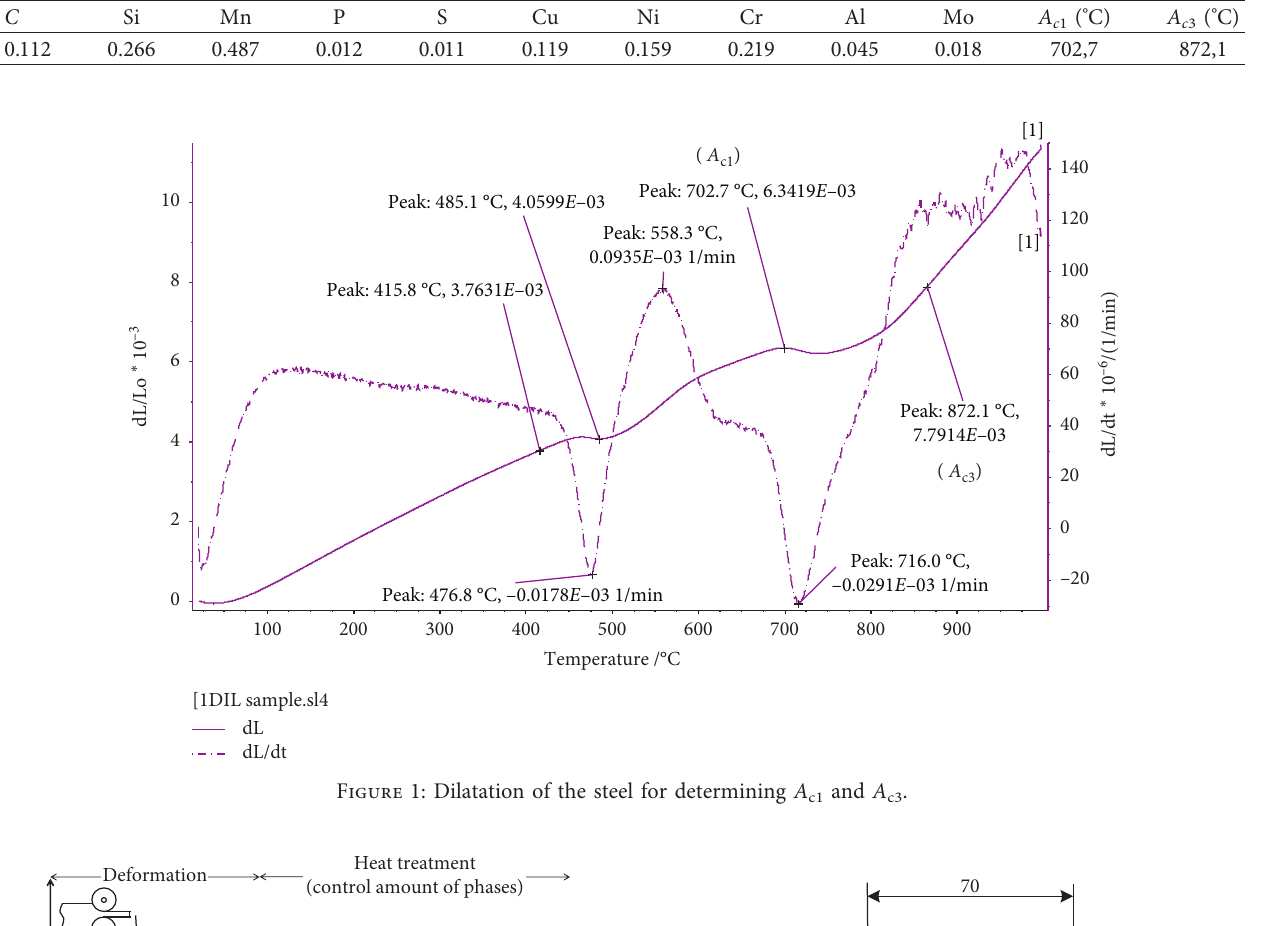
Table 1: Chemical composition (wt%) and A